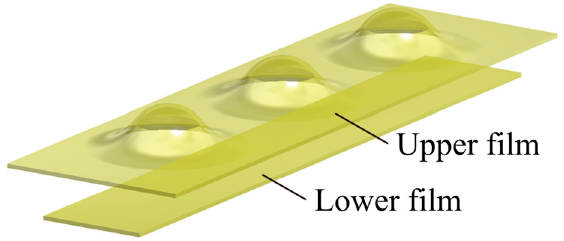
Figure 13. Two films for the fabrication of pod structure.